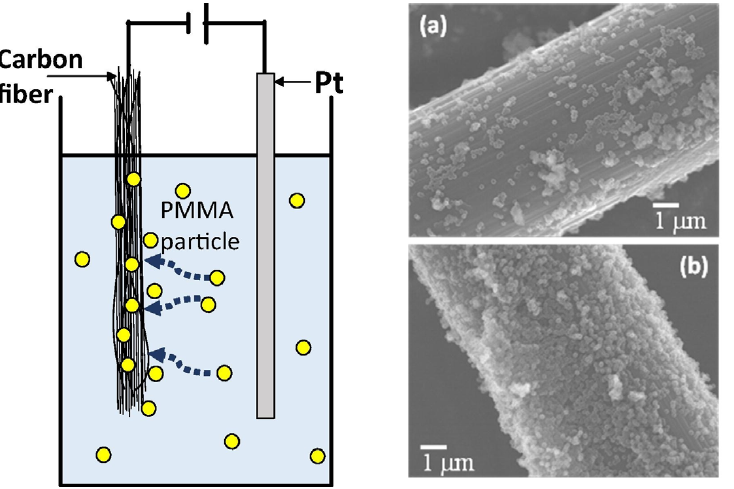
Figure 11. Depositing PMMA polymer colloid particles on CF via EPD (left) and SEM modified CFs at an applied voltage of ( a ) 6.5 V, ( b ) 20 V (right) (reprinted with permission) image of PMMA modified CFs at an applied voltage of ( a ) 6.5 V, ( b ) 20 V (right) (re- printed with permission) [90].